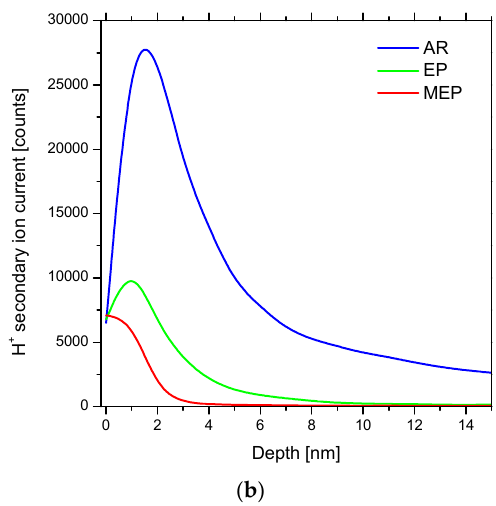
Figure 16 . Comparison of plots obtained for H + ion currents against the depth of ion etching: ( a ) range of 0 to 65 nm, and ( b ) results covering range of etching from 0 down to 15 nm. In Figure 16b—smoothed data (B-Spline) are presented.